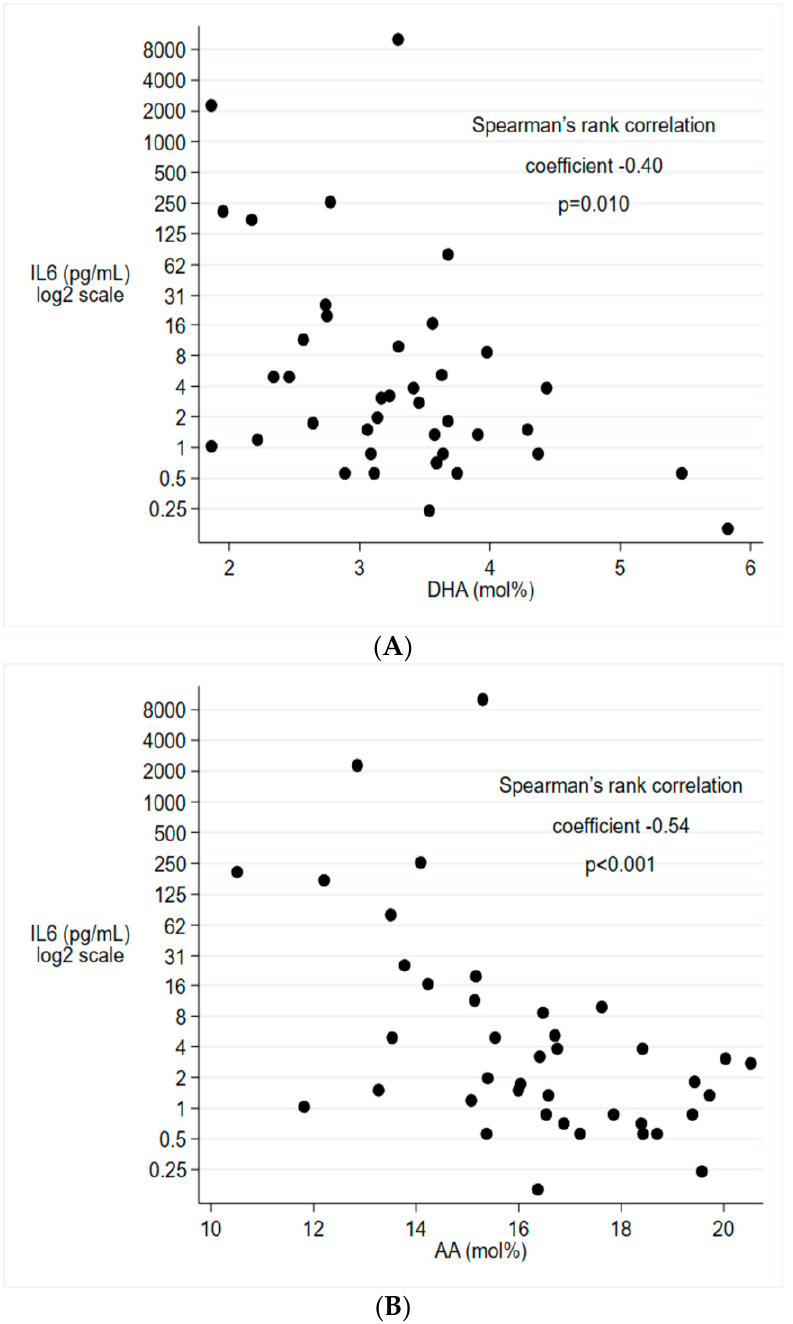
Figure 1. Associations between IL ‐ 6 and ( A ) DHA, ( B ) AA in cord blood.IL ‐ 6 presented on log 2 scale. n = 40. Abbreviations: IL ‐ 6, interleukin ‐ 6, DHA, docosahexaenoic acid; AA, arachidonic acid. Table 3. Levels of DHA and AA in cord blood, in infants with and without histological signs of chorioamnionitis and fetal inflammation respectively.